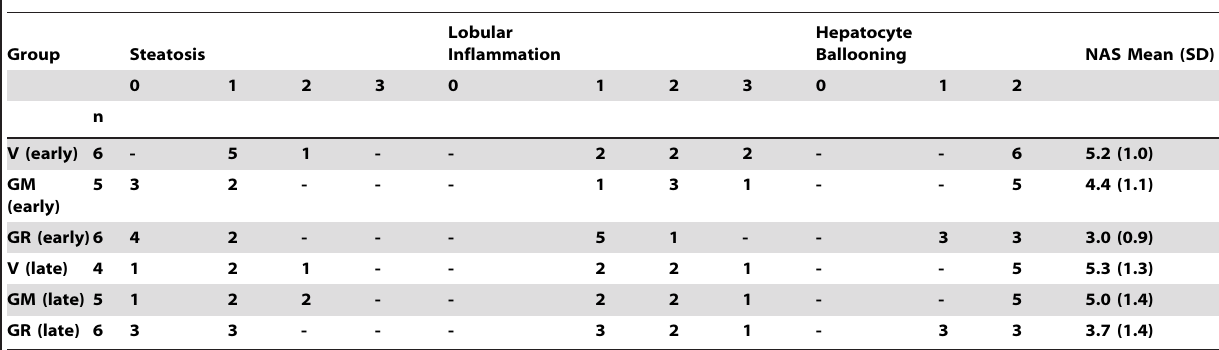
Table 1. Assessment of NAFLD Activity Score (NAS).